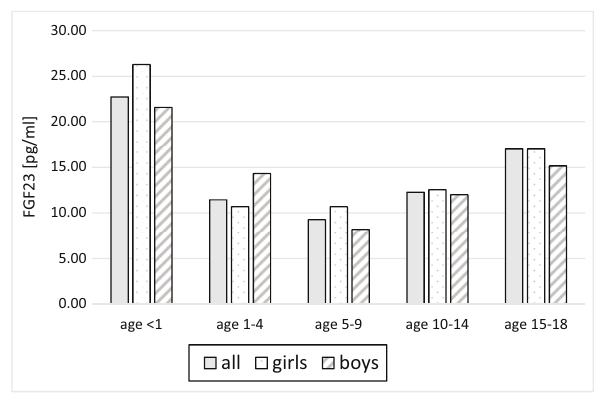
Figure 1: FGF23 levels in age groups – total and with sex distribu - tion. Median of values is presented, p > 0.05.